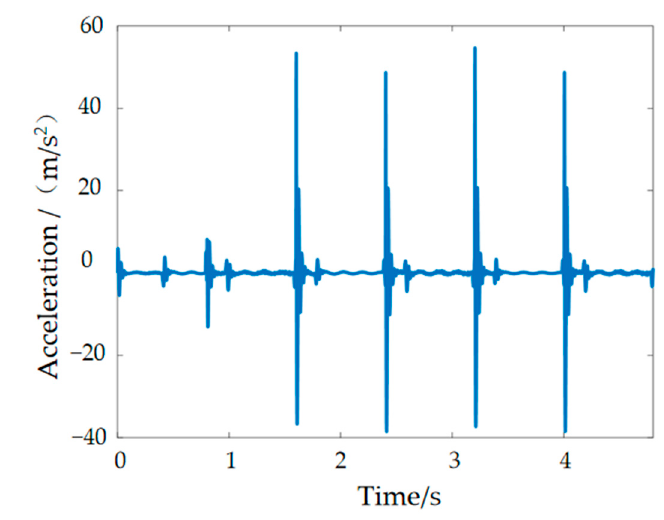
Figure 3. Plantar vibration and impact signals.